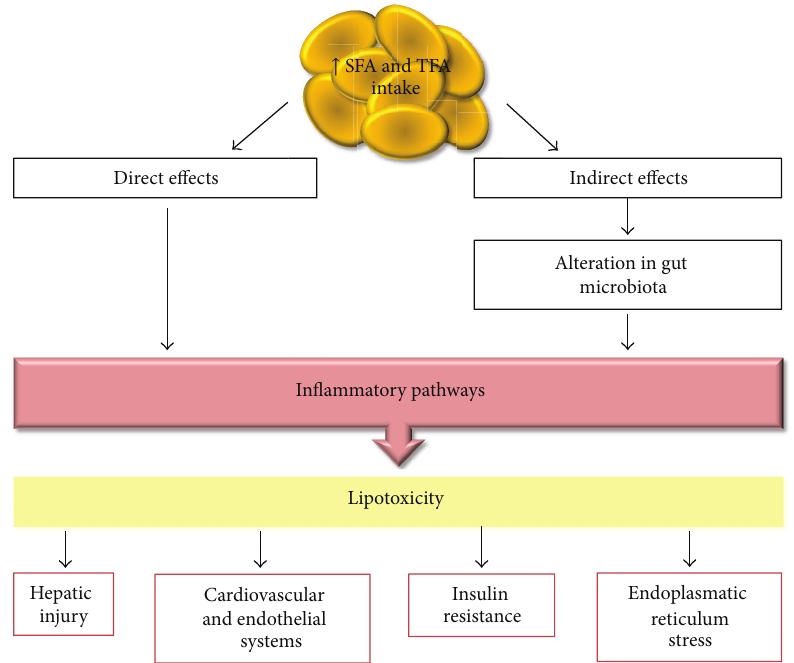
F 5: Schematic representation of SFA and TFA excess intake effects in the development of lipotoxicity in several target